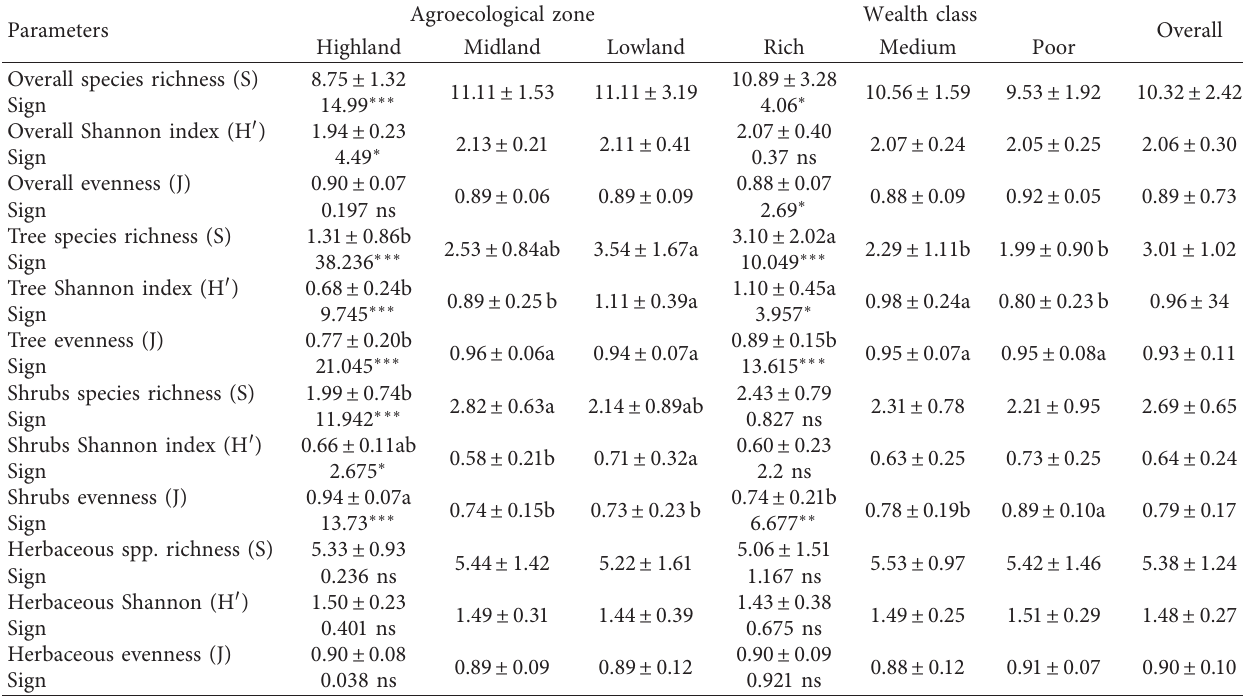
Table 5: Richness (s), Shannon (H ′ ), and evenness (J) of total plant species across the agroecological zones and wealth status of farmer in the study